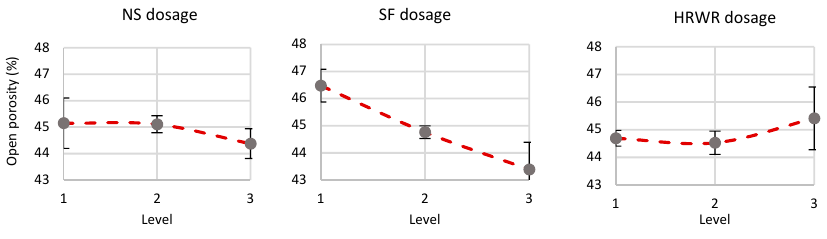
Figure 9. Influence of factors on open porosity values.